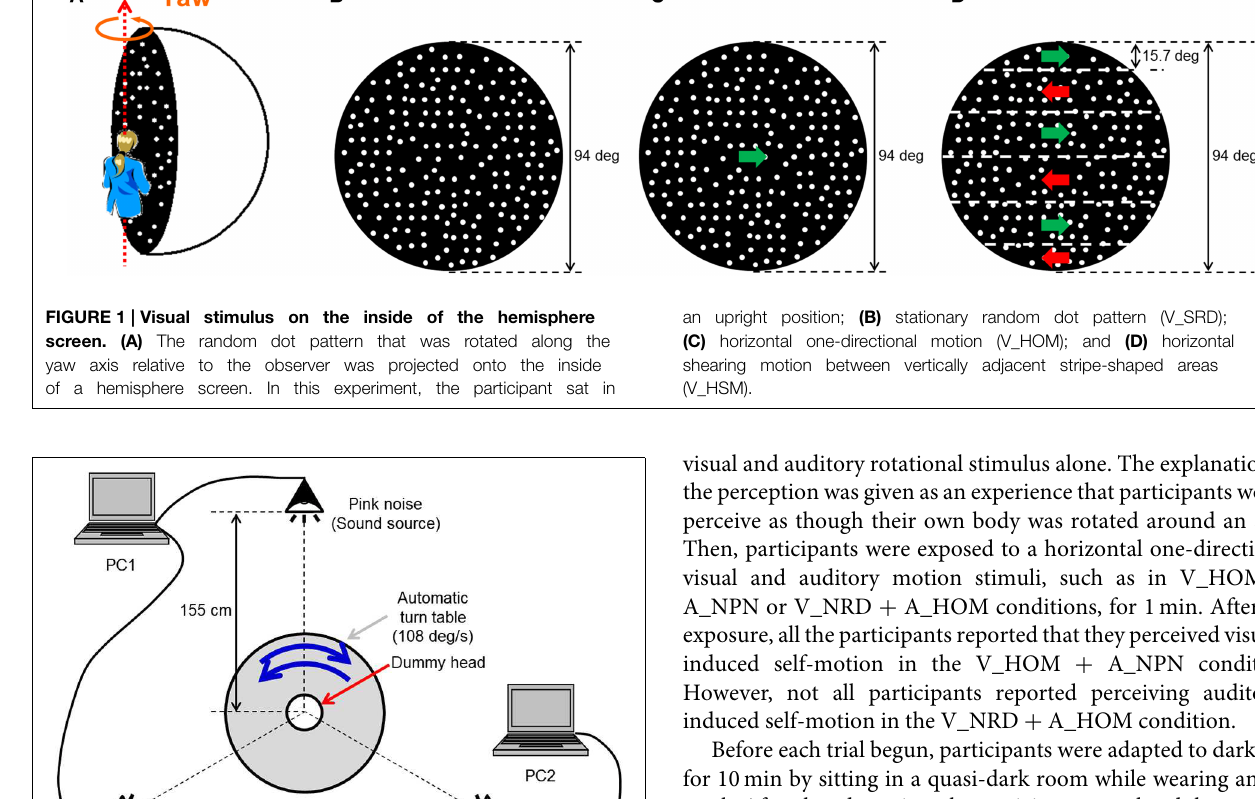
FIGURE 2 | The rotational auditory stimulus. A pink noise was output by two notebook computers through three loudspeakers located at an equal distance and an equal angle from the rotating base. This auditory stimulus was recorded by a dummy head with a binaural